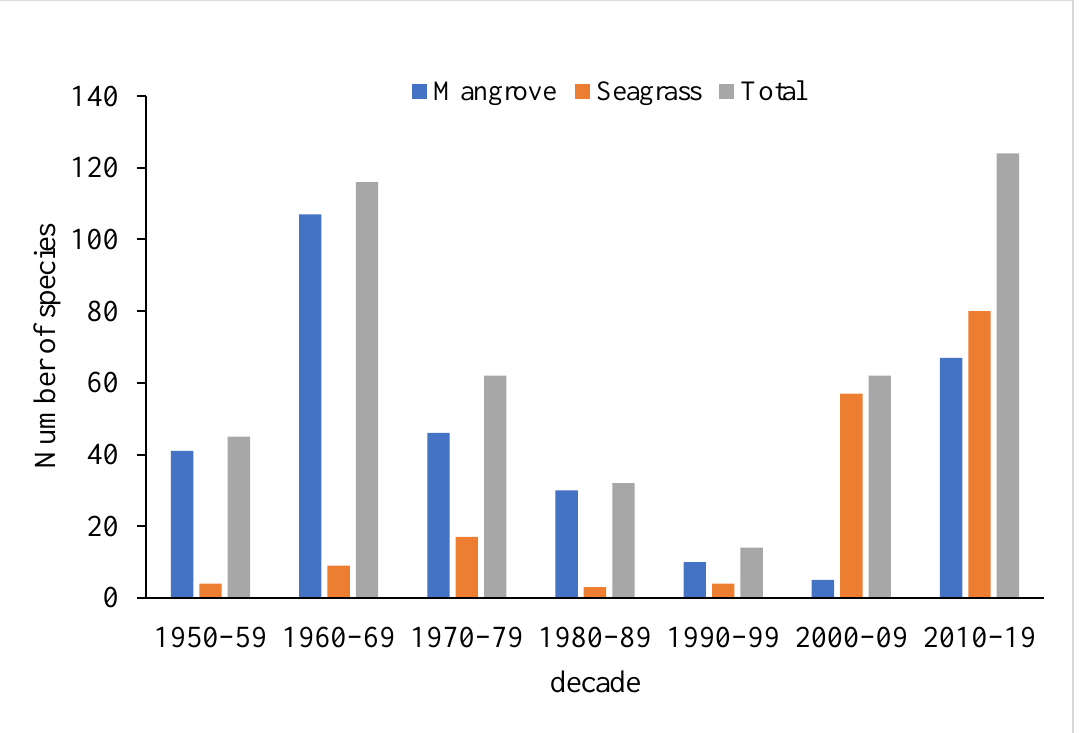
Figure 2 . Marine invertebrate species richness (S) in Maputo Bay(mangrove forests, seagrass meadows and total) per decade.